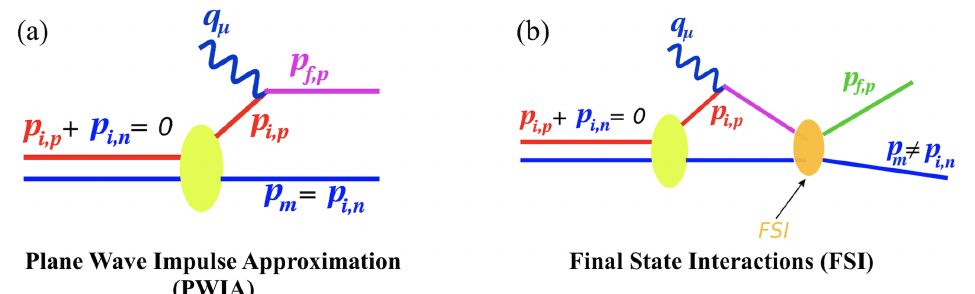
Figure 1. Electron scattering interaction probing deuterium (green blob) with ( a ) breakup and ( b ) re-scattering effects in the initial deuterium rest frame [36]. See text for